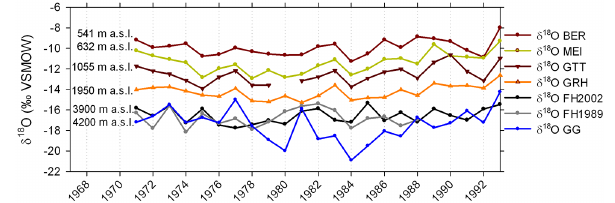
Figure 4. Annual precipitation-weighted δ 18 O from the GNIP sta- tions together with the ice core data. The sites are indicated as fol- lows: Bern (BER), Meiringen (MEI), Guttannen (GTT), Grimsel Hospiz (GRH), Fiescherhorn (FH), Grenzgletscher (GG). The gaps in the GNIP data are due to missing data points for the correspond- ing years. The altitude of each site is indicated on the left.